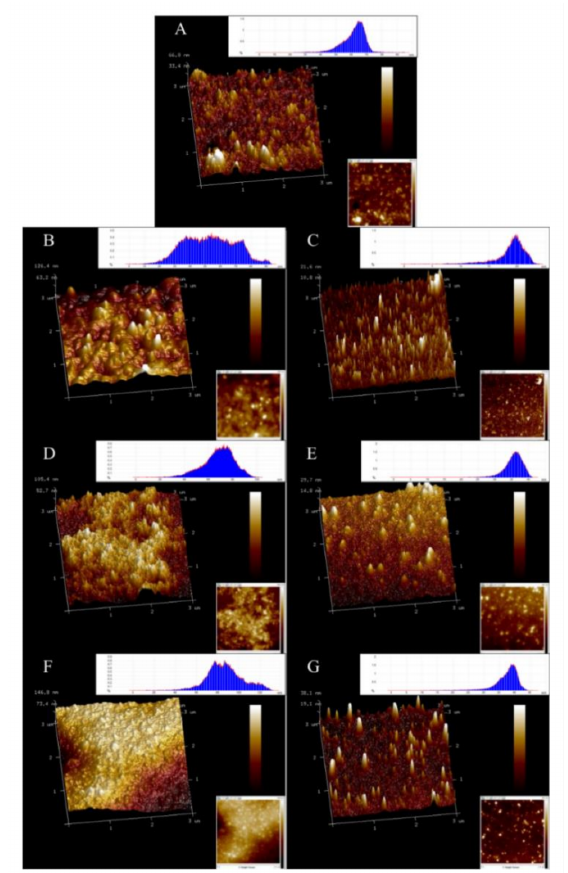
Figure 5. The 3D-view height-view (bottom right illustration) and cross-section (upper right illustra- tion) Atomic Force Microscope (AFM) image of SPI oxidized before and after cavitation jet treatment. Note: Scale bar is 3 µ m. ( A )–( G ) represents protein